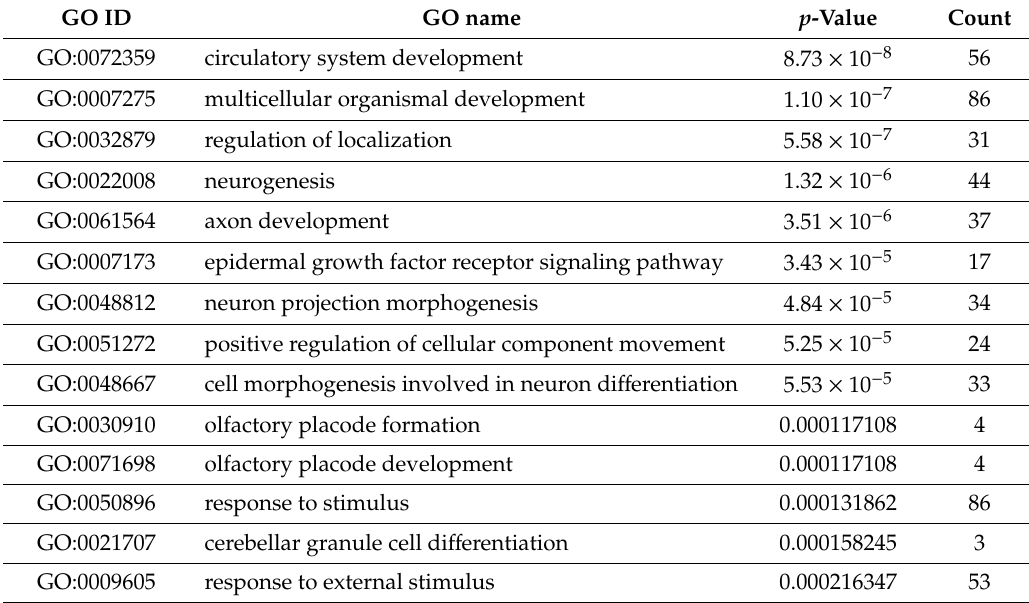
Table 2. Gene Ontology (biological process) analysis of down-regulated genes after PROX1 silencing in CGTH-W-1 cells.